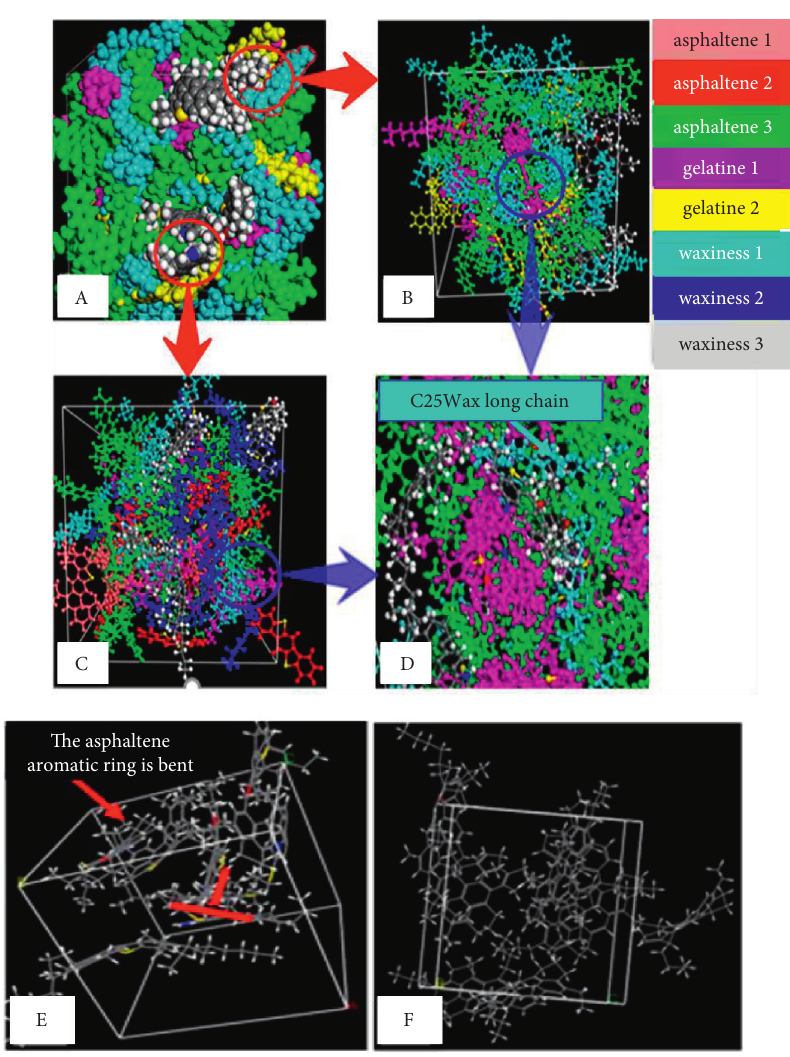
Figure 3: GROMACS software simulated the molecular interaction between wax and